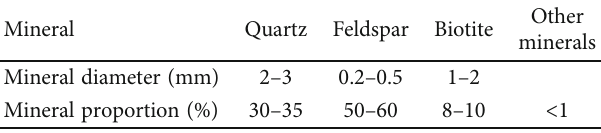
Table 1: Mineral compositions of granite specimen.